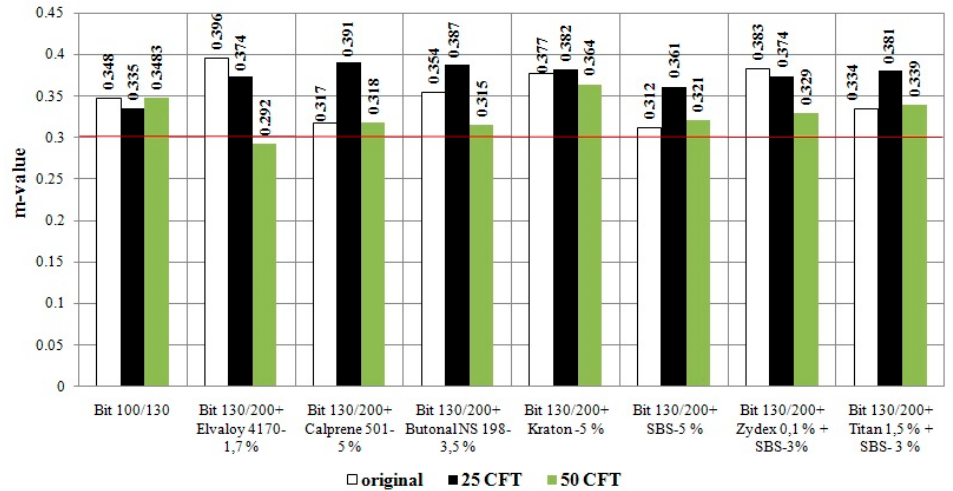
Figure 12. Bitumens m-value at the temperature of –36° С .